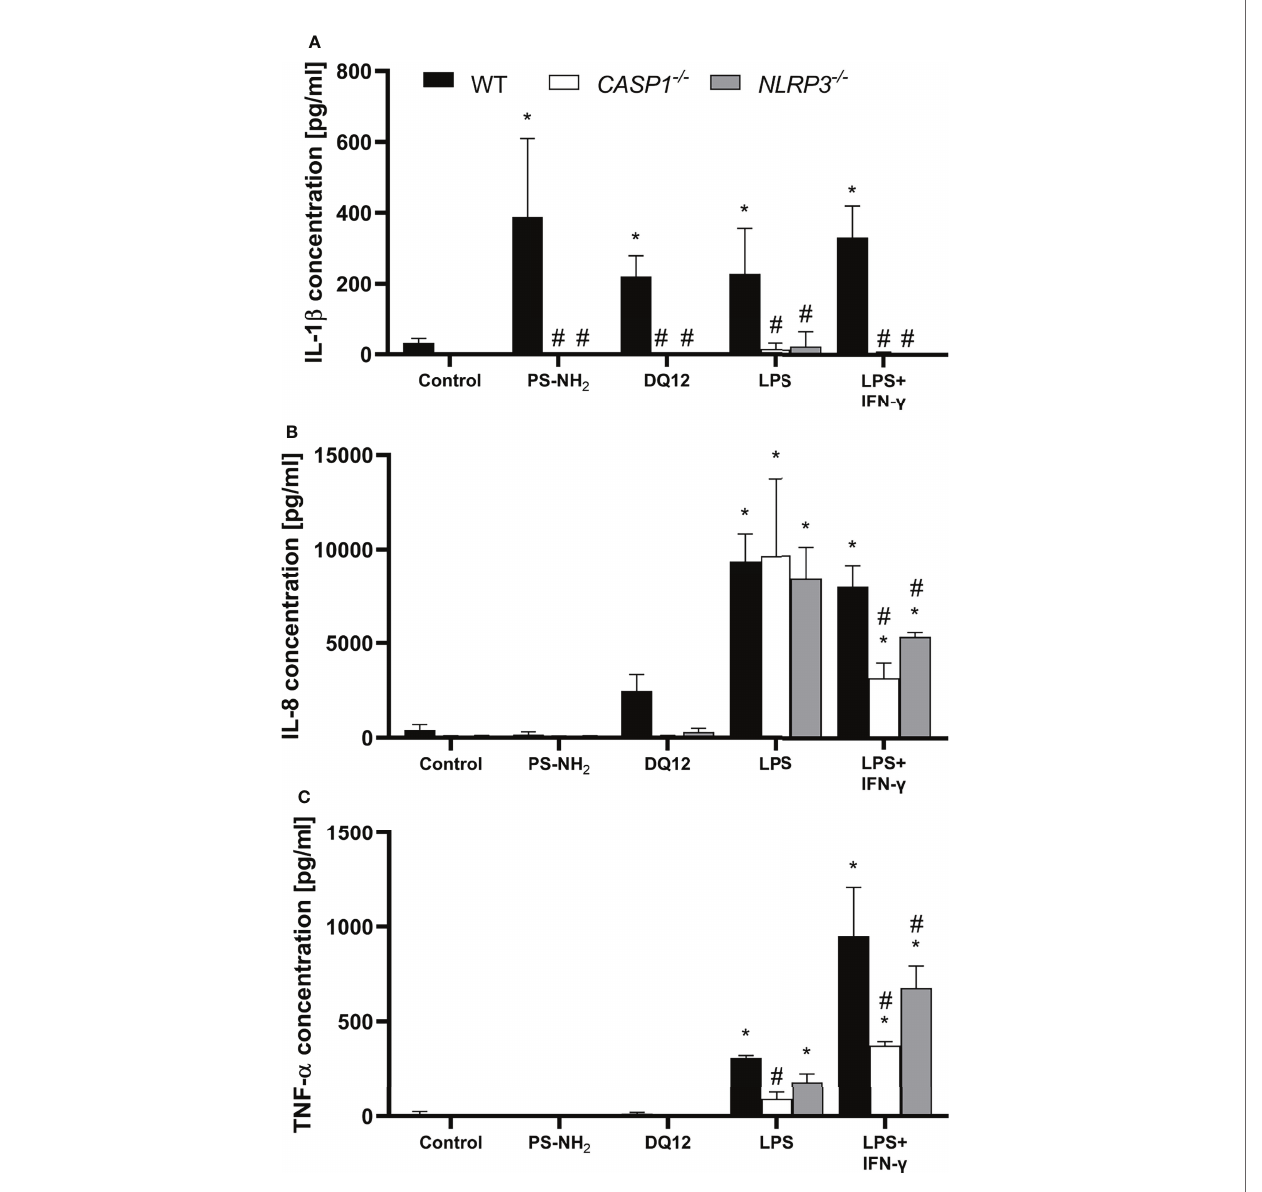
FIGURE 1 | Secretion of (A) IL-1 b , (B) IL-8 and (C) TNF- a into the supernatant by differentiated THP-1 cells (wild type, CASP1 -/- or NLRP3 -/- ) after 24 h incubation with 10 μg/cm² amine-modi fi ed polystyrene nanobeads (PS-NH 2 ), 200 μg/cm² crystalline silica (DQ12), LPS (10 ng/ml) or LSP/IFN- g (both 10 ng/ml). Mean ± SD of N = 3; *p < 0.05, compared to the untreated control; # p < 0.05, compared to the WT of the same treatment